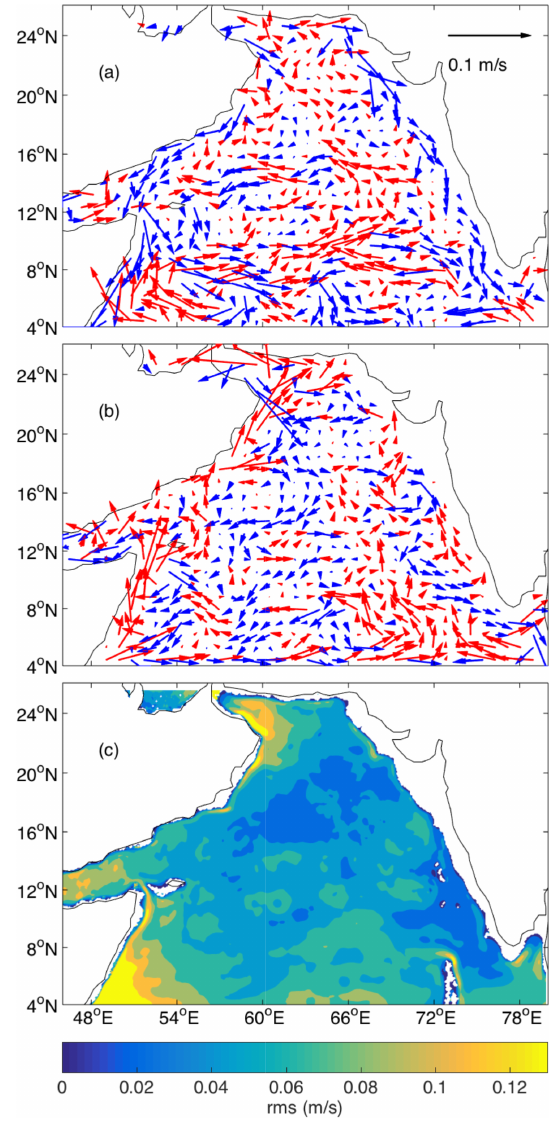
Figure 5. Mean seasonal velocity for the Arabian Sea based on HYCOM for the isopycnal surface of σ = 27kgm − 3 in the depth range of 450 to 500m for the (a) northeast (November–February) and (b) southwest monsoon (June–September) averaged from 2000 to 2012. The velocity field is spatially filtered (0 . 6 ◦ × 0 . 6 ◦ win- dow) and presented on a grid with the same resolution. Northward- directed (southward-directed) currents are shown in red (blue). (c) Root mean square (rms) error of the annual mean velocities from 2000 to